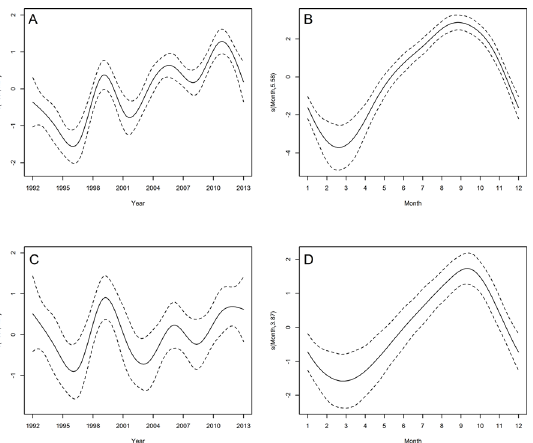
Fig 8. Temporal trends in South American fur seal strandings. Estimated smooth function (solid line) with 95% confidence interval (dashed lines) for the fitted GAM by year and month from 1992 to 2013. Neonates (A and B) and juveniles/adults (C and D). Y-axis = fitted function with estimated degrees of freedom in parentheses.